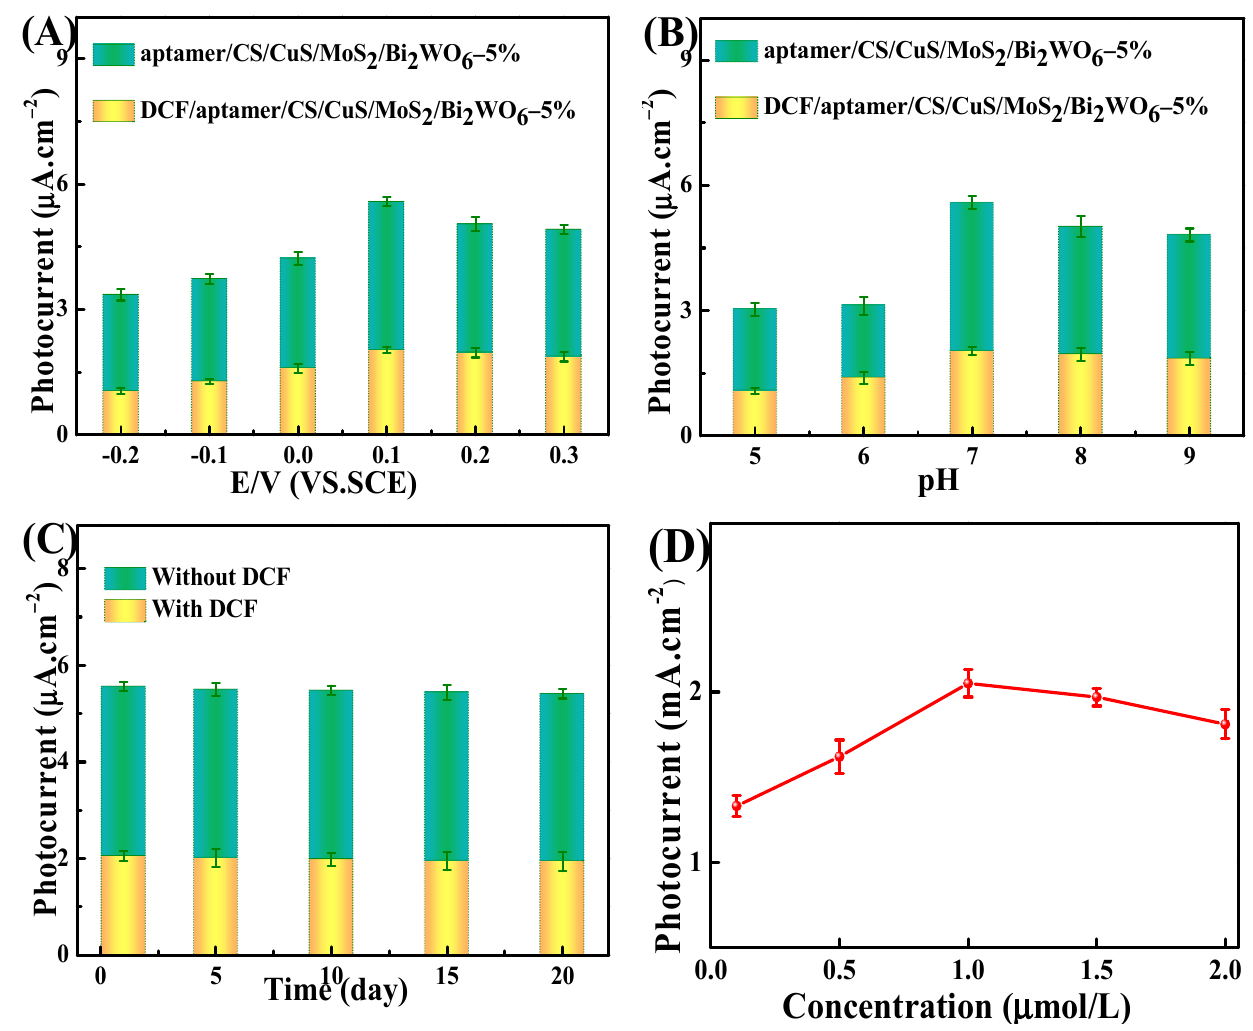
Figure 7. ( A ) the applied potential selection, ( B ) the electrolyte of pH selection, ( C ) stability test of PEC aptasensor, and ( D ) impacts of aptamer concentration on the photocurrent response of the aptasensor based on aptamer/CS/CuS/MoS 2 /Bi 2 WO 6 -5%. Aptamer/CS/CuS/MoS 2 /Bi 2 WO 6 -5% was used to analyze DCF concentrations under optimized circumstances. According to Figure 8A, the photocurrent increased in proportion to the DCF concentration due to the aptamer’s specific binding to DCF. The generated DCF–aptamer complexes on the sensor interface reduced the steric barrier for electron-donor diffusion, resulting in a drop in photocurrent. Within the concentration range of 0.1 to 500 nM (Figure 8B), the photocurrent change followed a linear relationship with the DCF concentration, resulting in a detection limit of 0.03 nM (S/N = 3). PI = 1.278 + 1.316logC was used as the calibration regression equation (nM). A correlation coefficient ( R 2 ) of 0.9965 was obtained. The suggested sensor’s performance, which included additional previously reported characteristics, demonstrated a substantially lower detection limit within a comparable linear range (Table